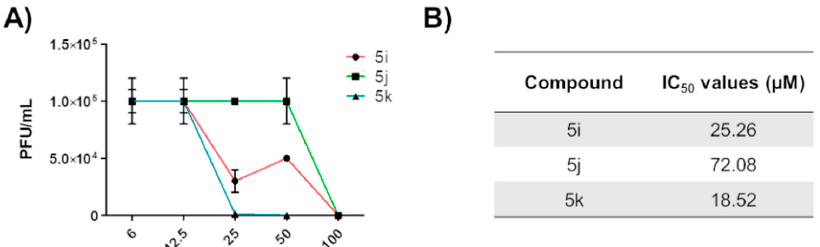
Figure 4. ( A ) Vero cells were infected with HSV ‐ 1 and, where indicated, the cells were treated with